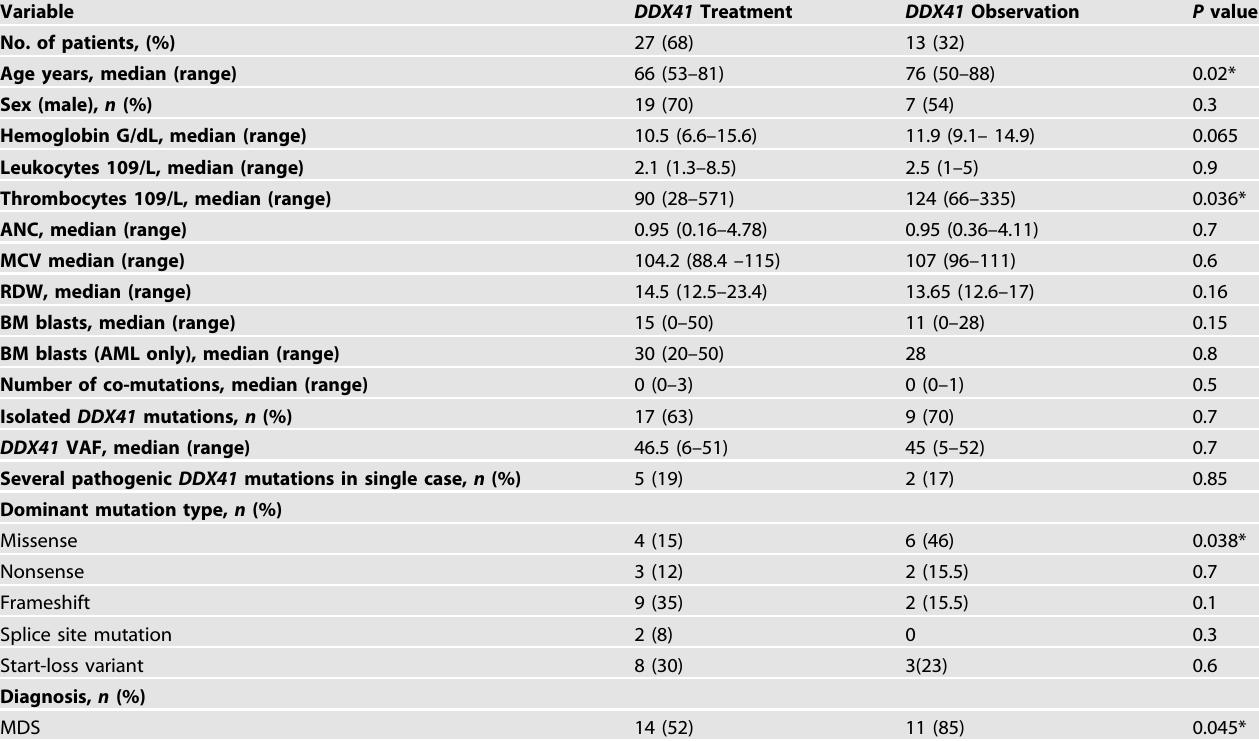
Table 1. Characteristics and hematological features of mutated DDX41 patients and comparison between treatment and observation